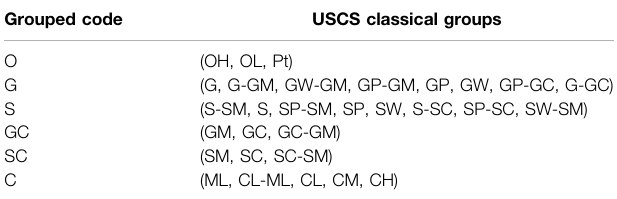
TABLE 2 | Grouped USCS codes. It indicates in which group code the classical USCS groups are rearranged. Grouped